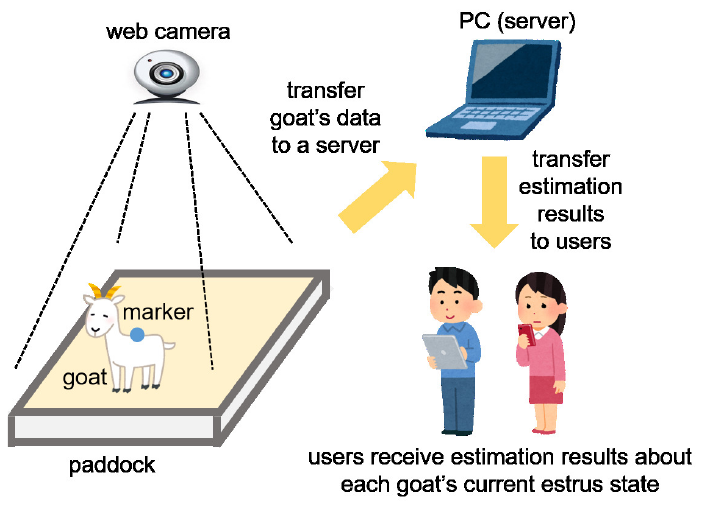
Figure 8. The proposed automated estrus estimation system for